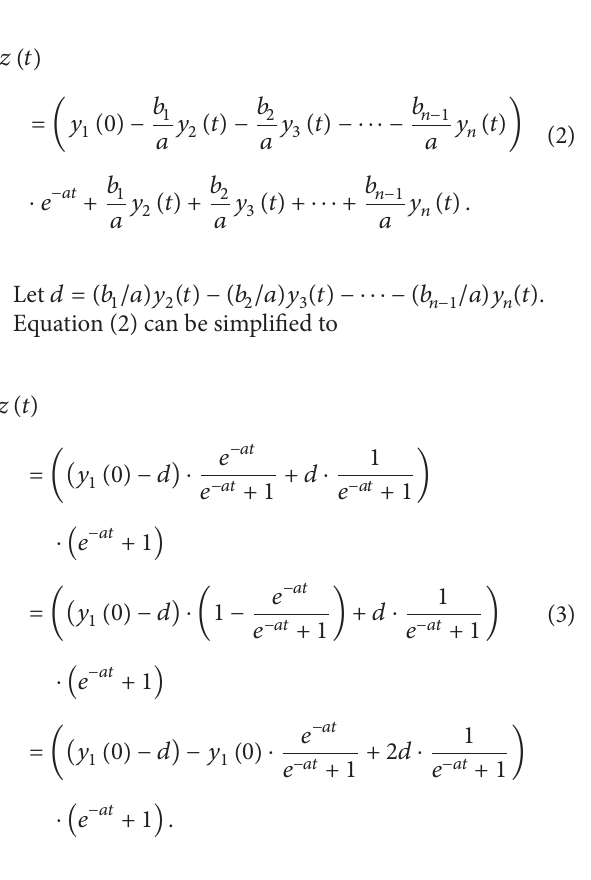
coefficient differential equations. The time response formula of (1)